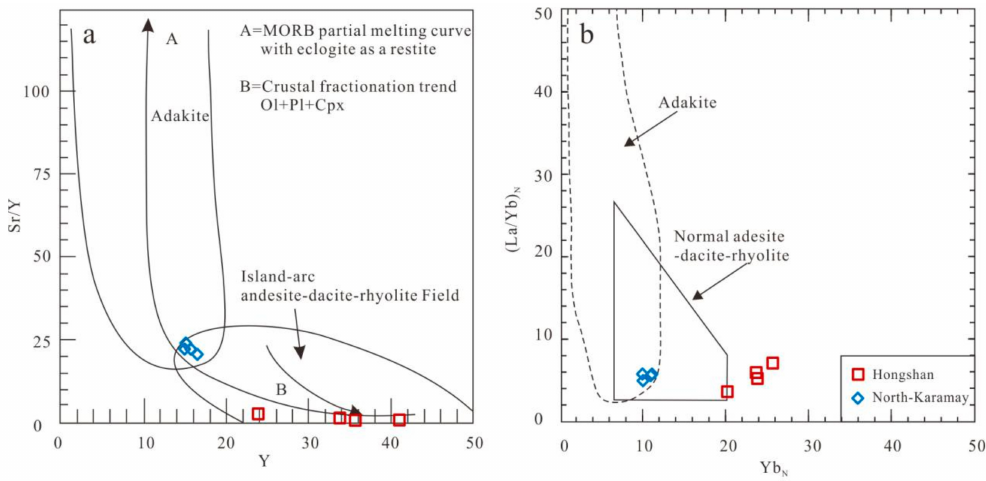
Figure 9. ( a ) Sr / Y vs. Y (after Defant et al. [79]), and ( b ) (La / Yb) N vs. (Yb) N diagrams (Geng et al.